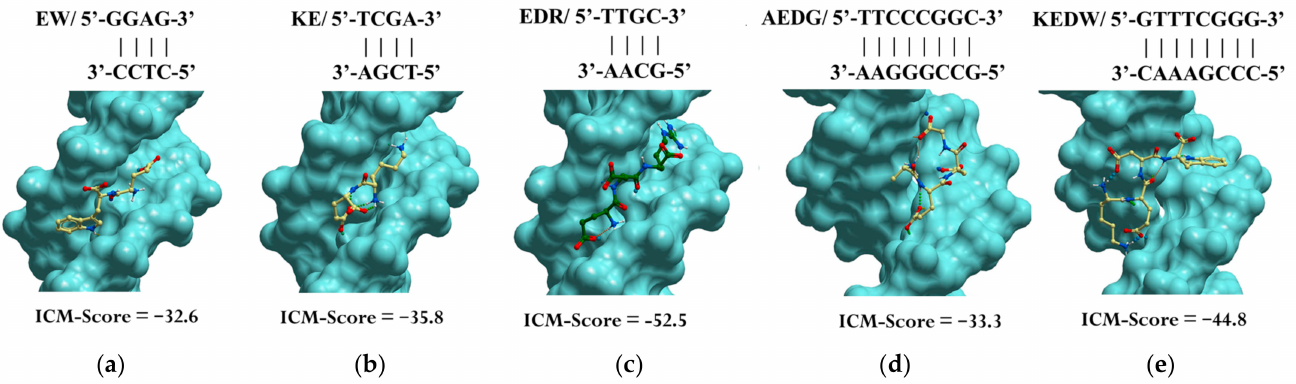
Figure 3. Site-specific binding of peptides EW ( a ), KE ( b ), EDR ( c ), AEDG ( d ), and KEDW ( e ) to double-stranded DNA in the classical B-form. Note: ICM-Score—the Internal Coordinate Mechanics binding score. Standard scheme of atom designation was following: C—yellow (green), N—blue, O—red.